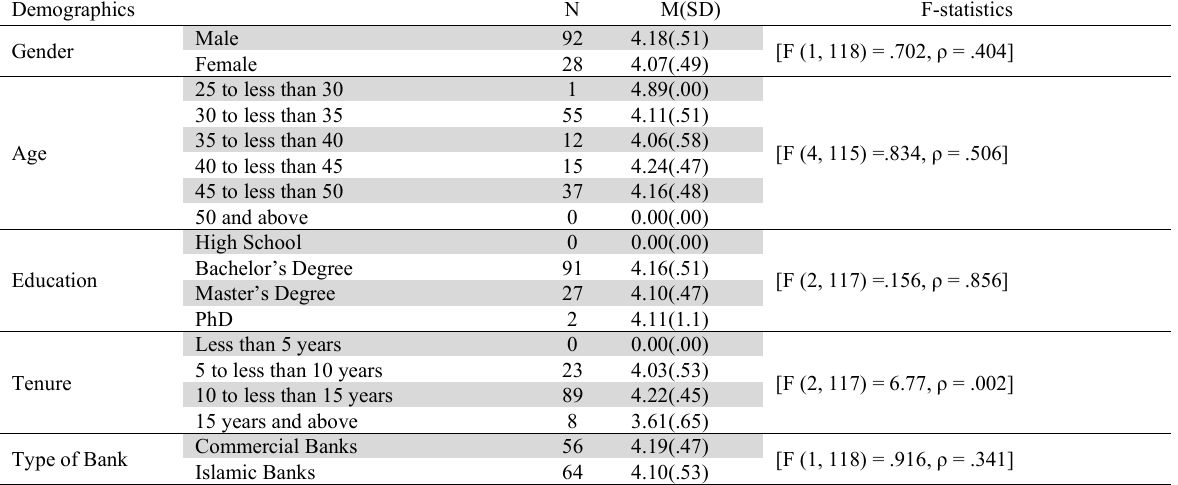
ANOVA for product innovation and demographics information